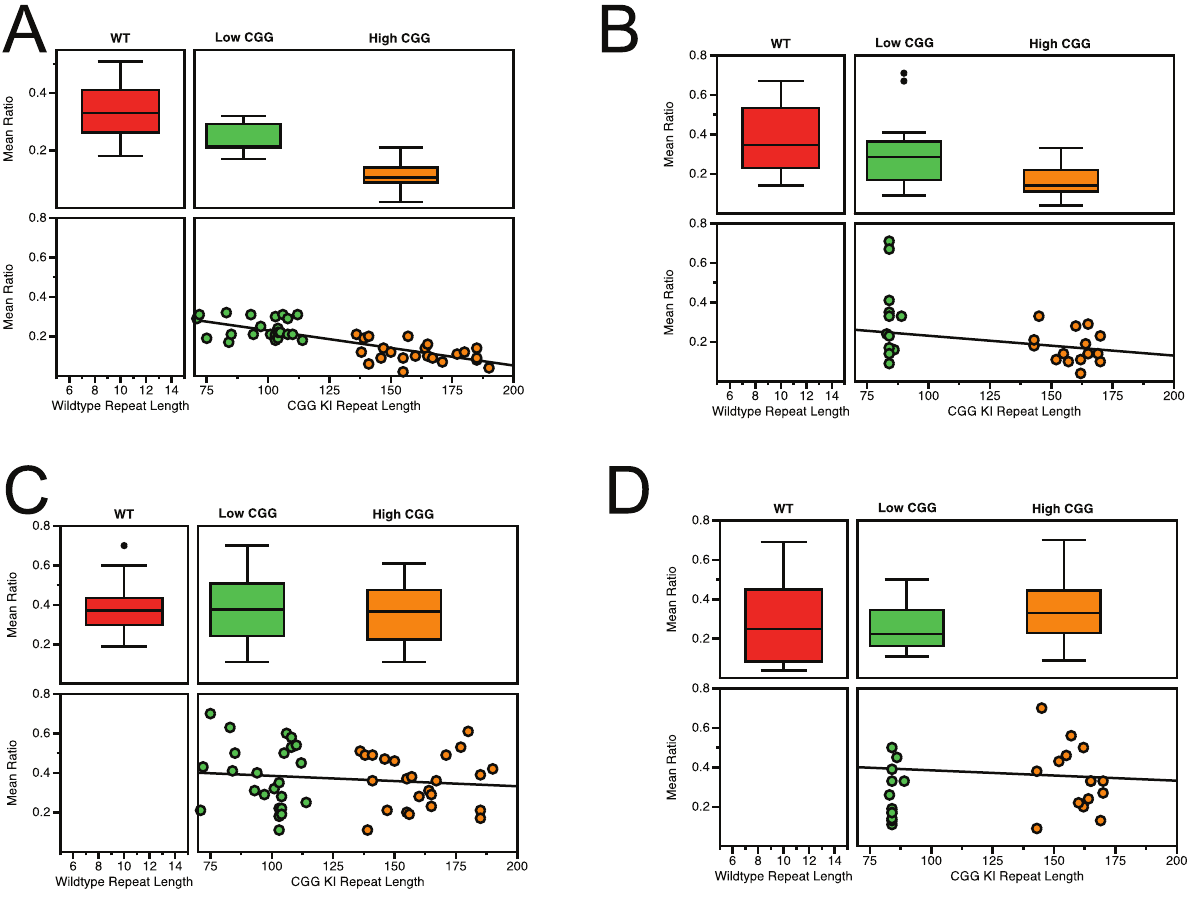
Figure 3. Temporal processing deficits in CGG KI mice scale with CGG repeat length and sex. A . Temporal Ordering for Visual Objects Task in male mice. B . Temporal Ordering for Visual Objects Task in female mice. C . Novelty Detection for Visual Objects Task in male mice. D